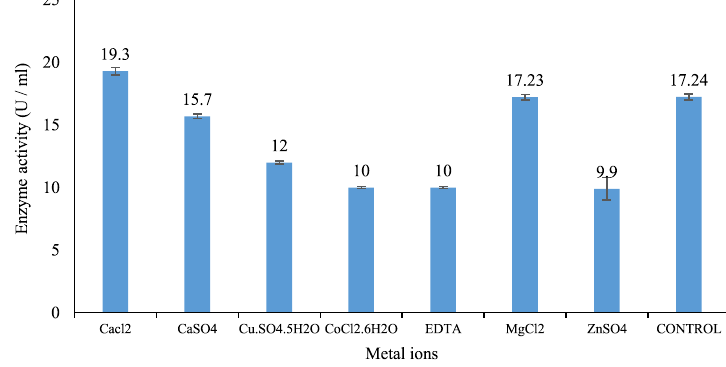
Fig. 15. Effect of different metal ions on activity of the purified β-xylosidase Table 5. Total protein content of T. viride and P. janthenellum Amino